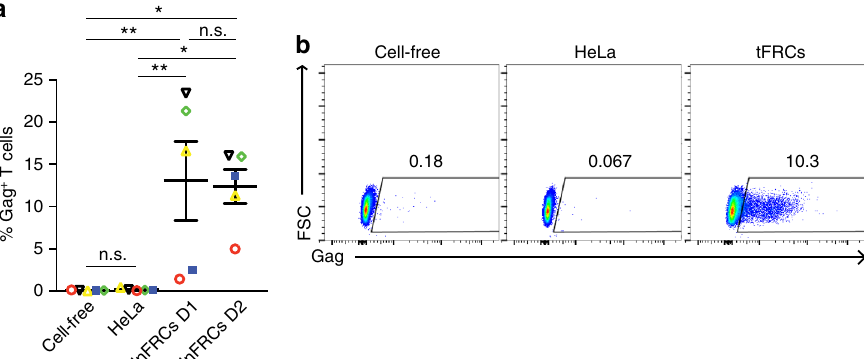
Fig. 3 FRCs mediate trans-infection of HIV-1 produced by HLACs. The ef fi ciencies of trans-infection of human lymphoid aggregate culture (HLAC)-derived virus mediated by HeLa cells, lnFRCs or tonsillar FRCs (tFRCs) were compared using fl ow cytometry. HeLa cells and lnFRCs or tFRCs were cultured in the presence of HIV-1 NL4-3 (25.4 ng p24) for 2 h, washed extensively, and cocultured with A3.01 T cells for 6 days. For the cell-free condition, A3.01 T cells were inoculated with the same amount of input virus and cultured for 6 days without removing the initial inoculum. a HLACs were prepared from the tonsils of fi ve different donors. Data represent the results of experiments performed using fi ve different virus stocks produced in these HLACs (each symbol corresponds to a virus stock prepared using HLACs of one unique donor). lnFRCs from two donors were used. b tFRCs and HLACs were prepared from the tonsils of the same donor in each experiment as detailed in Methods. Trans-infection of HIV-1 propagated in HLACs by tFRCs isolated from the same tonsil donor was examined. A representative set of the results obtained using tFRCs and HLACs from one donor is shown. The data obtained with tonsillar cells from all fi ve different donors are shown in Supplementary Fig. 2. The mean ± SEM is shown. The p -values were determined using Tukey ’ s test following one-way ANOVA. * p < 0.05; ** p < 0.01; n.s., not signi fi